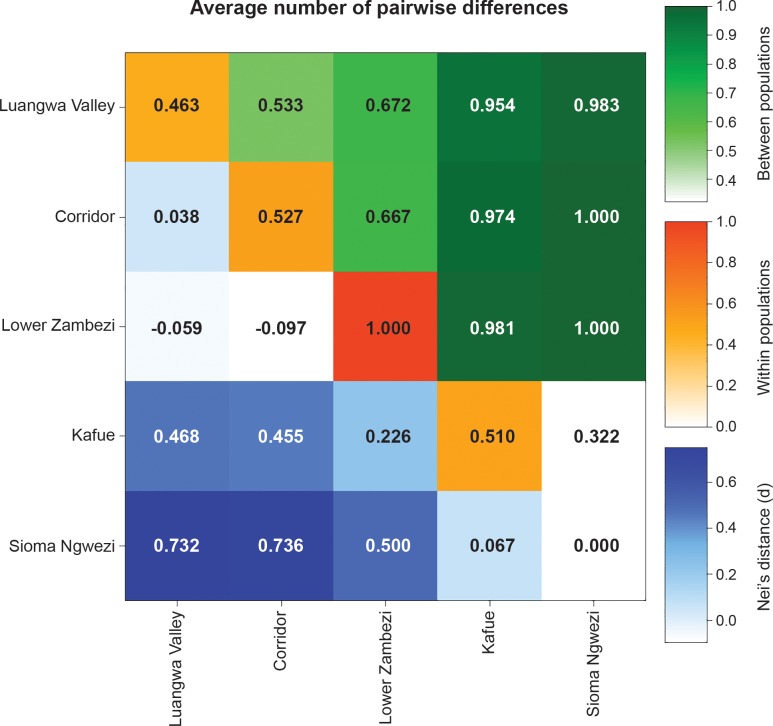
Nei’s distance (d) and average number of pairwise differences within and between populations.